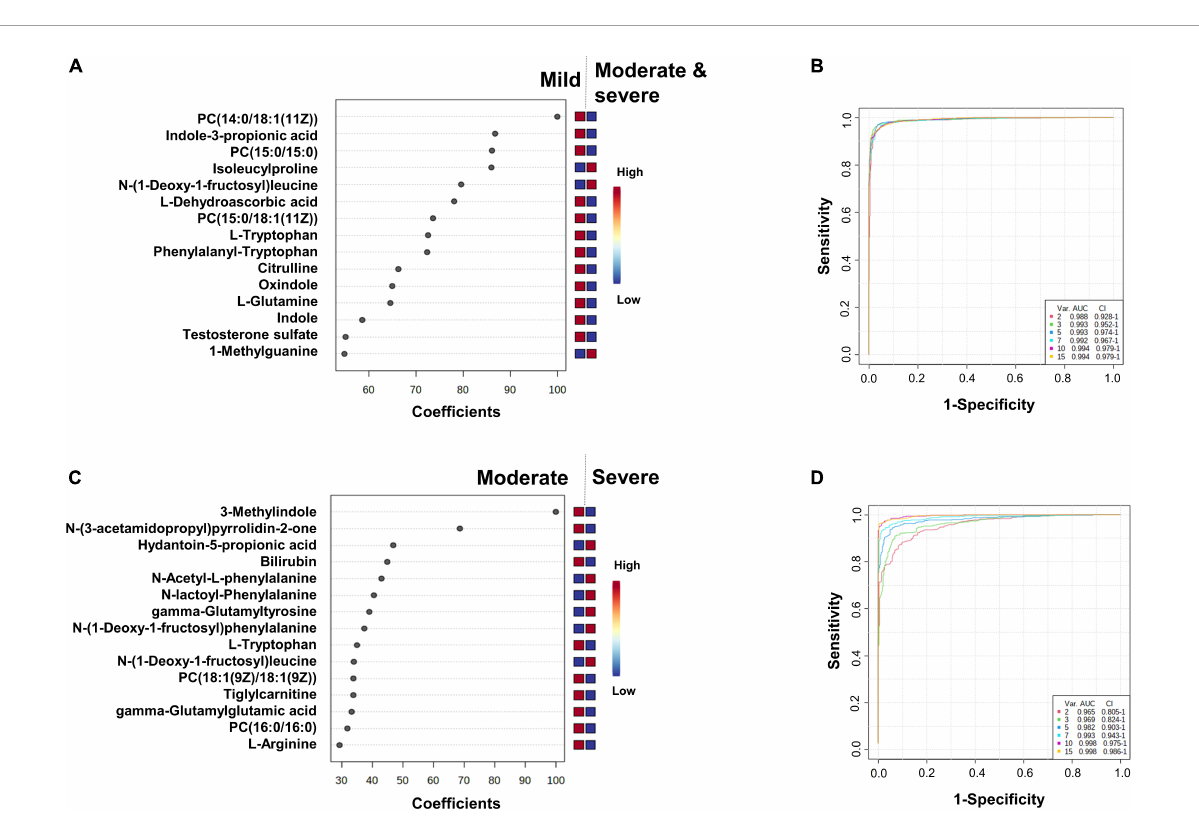
FIGURE4 Identification of the putative biomarkers of moderate and severe COVID-19 patients compared to mild SARS-CoV-2 infected subjects (A,B) and severe compared to moderate COVID-19 patients (C,D) . PLS-DA analyses are shown in Supplementary Figure 2A and Figure 3A . Loading plots of the top 15 metabolites selected on the average of the first five components of the PLS-DA model. Identified features were MS2 validated and are shown as chemical names (A,C) . Pairwise comparisons of areas under multivariate ROC curve (AUC) from each prognosis predictor (B,D) .